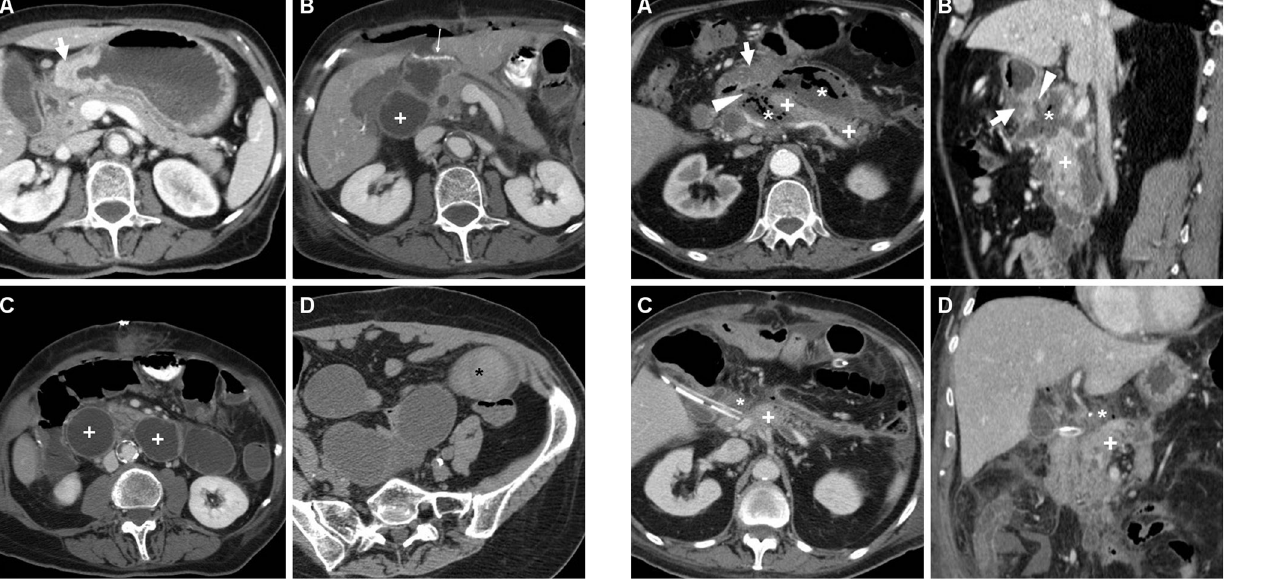
Fig. 16 An 84-year-old male with lesser sac and pancreatic abscess (* in A, B) from retroperitoneal perforation of pyloric peptic ulcer (arrowheads) underwent emergency surgery, including subtotal gastrectomy with Billroth II reconstruction. Note pancreatic parenchyma (+), oedematous thickening of pylorus submucosa (thick arrows). On 7th POD surgical revision was required due to DS biliary leakage, with